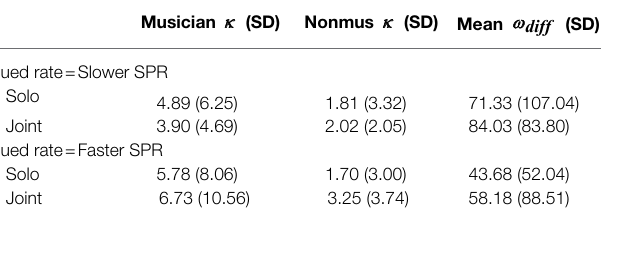
TABLE 1 | Mean model parameter values for Musicians and Nonmusicians by Faster/Slower Cued Rate and